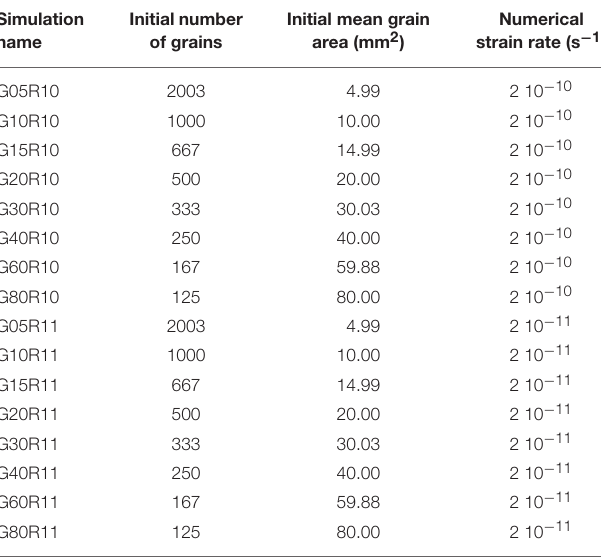
TABLE 2 | Overview of crucial input parameters used for the numerical